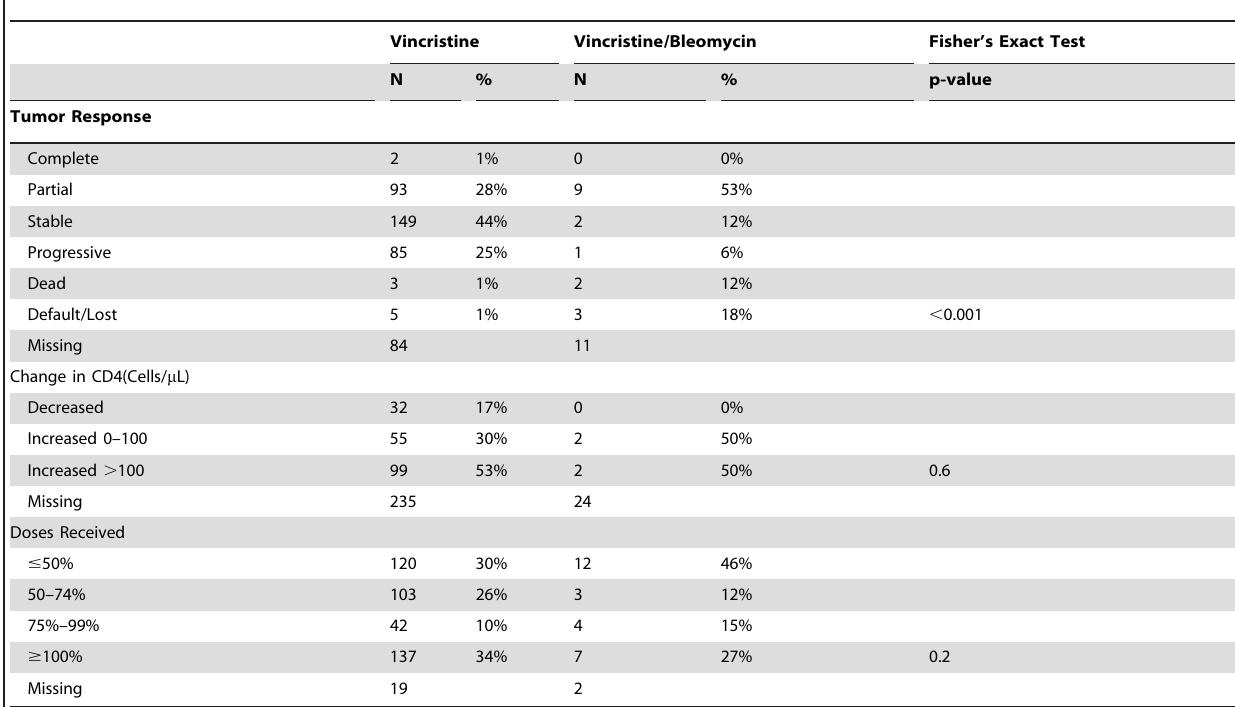
Table 2. Outcomes by treatment